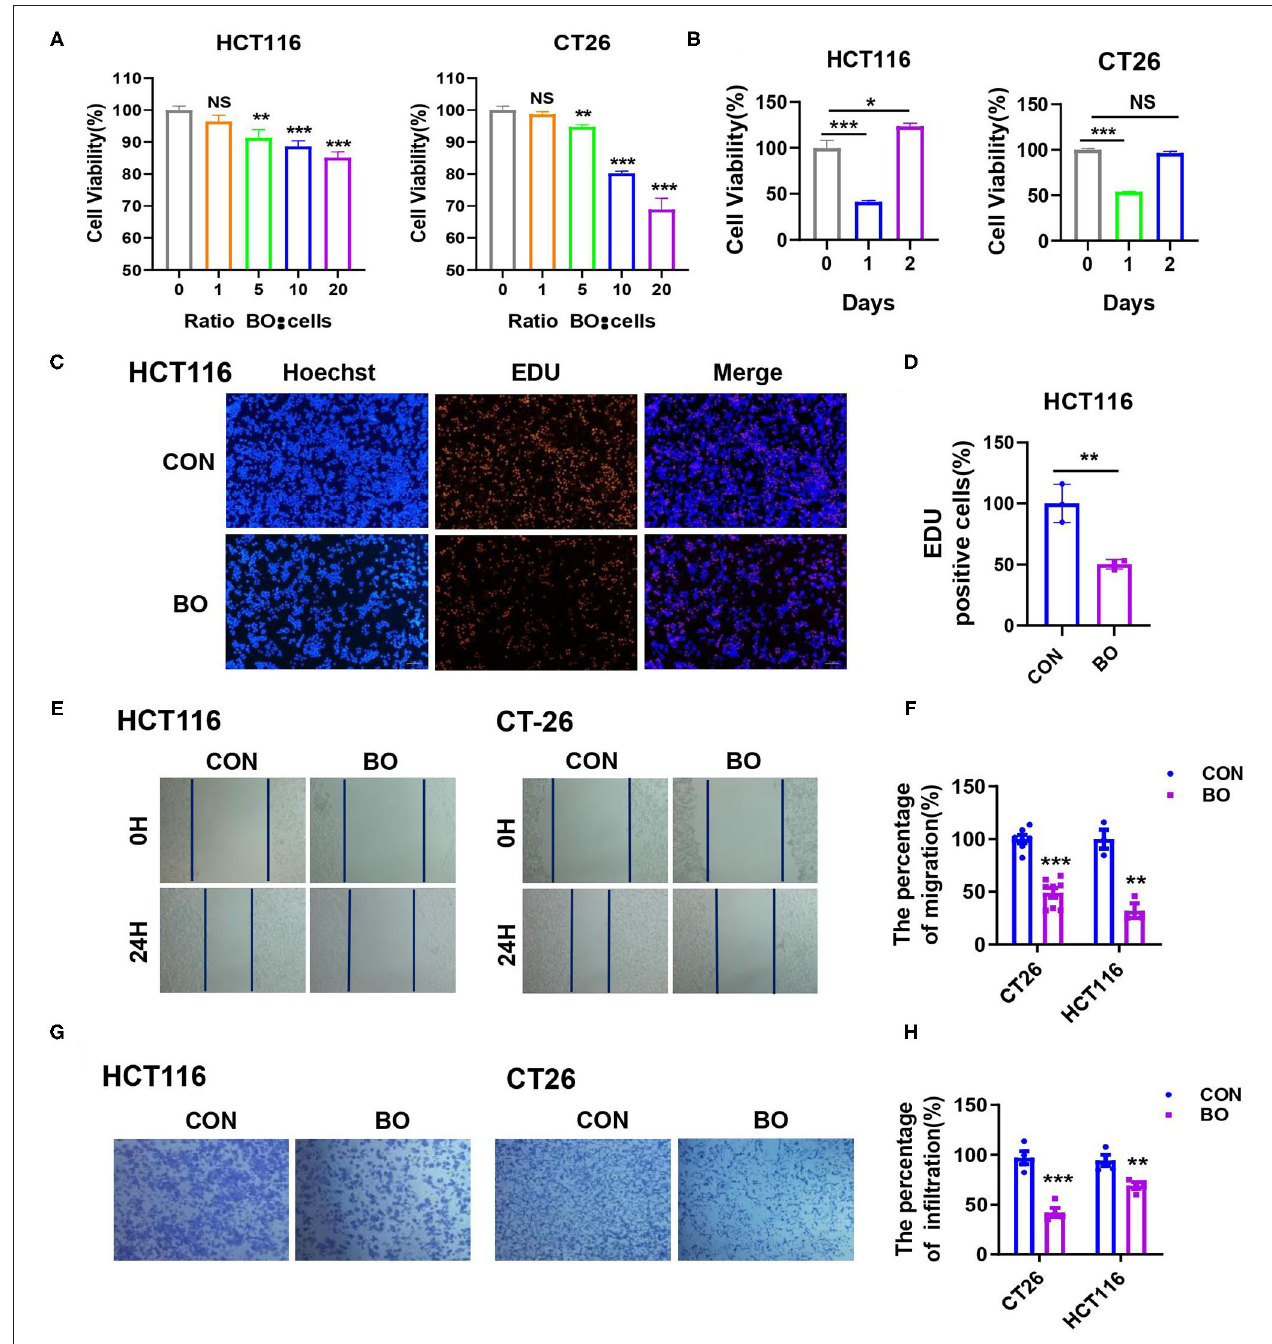
FIGURE 3 | Bornlisy inhibits proliferation and metastasis of colorectal cancer (CRC) cells in vitro . (A) The HCT116 and CT26 cells were treated with BO of different concentrations for 24h. The cell proliferation was measured by CCK8 assay. (B) The HCT116 and CT26 cells were treated with BO (multiplicity of infection [MOI] = 5) for different days. The cell proliferation was determined by the CCK-8 assay. (C,D) The HCT116 cells were treated with BO (MOI = 5, 24h). The cell proliferation was evaluated using immunofluorescence staining. The EdU-positive cells were calculated (scale bar, 100 µ m). (E,F) The HCT116 cells and CT26 cells were treated with BO (MOI = 5, 24h). The migratory ability was detected by wound healing assays. The percentage of migration was measured. (G,H) The HCT116 cells and CT26 cells were treated with BO (MOI = 5, 24h). The infiltration ability was detected by a transwell assay. The percentage of infiltration was measured. Data with error bars are presented as mean ± SD. Each panel is a representative experiment of at least three independent biological replicates. * P < 0.05, ** P < 0.01, and *** p < 0.001 as determined by unpaired Student’s t -test.